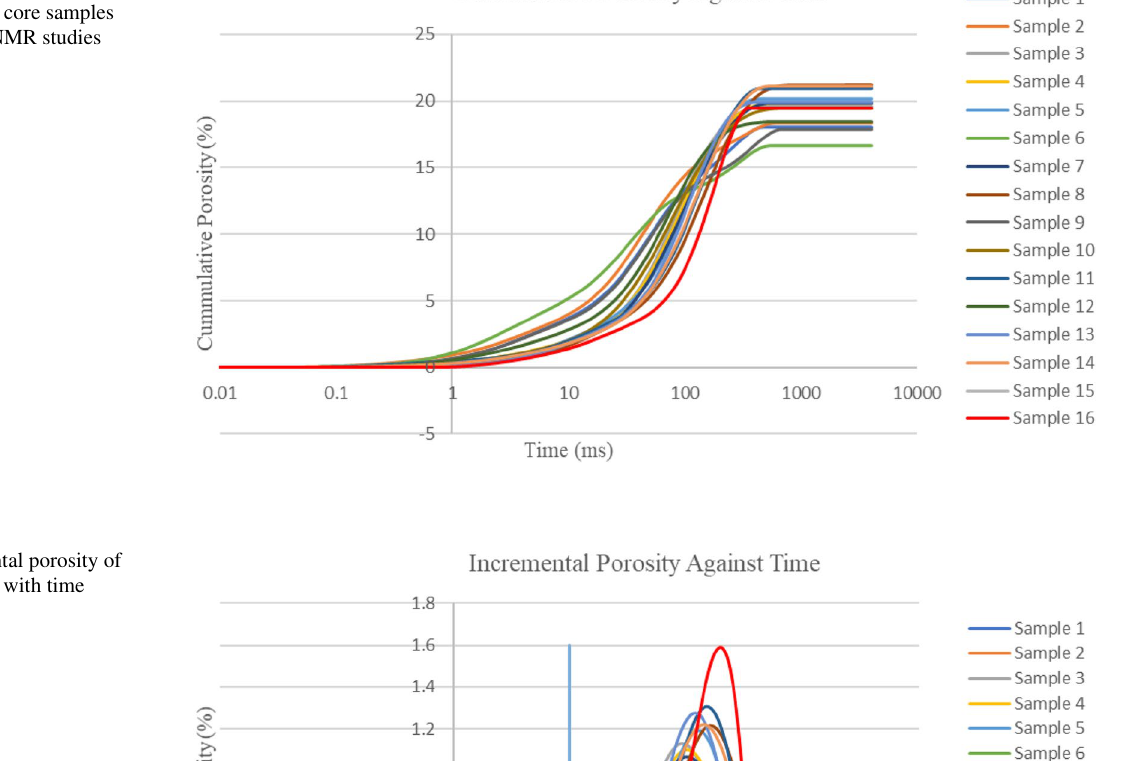
Fig. 2 Cumulative porosity with time for various core samples obtained from NMR studies